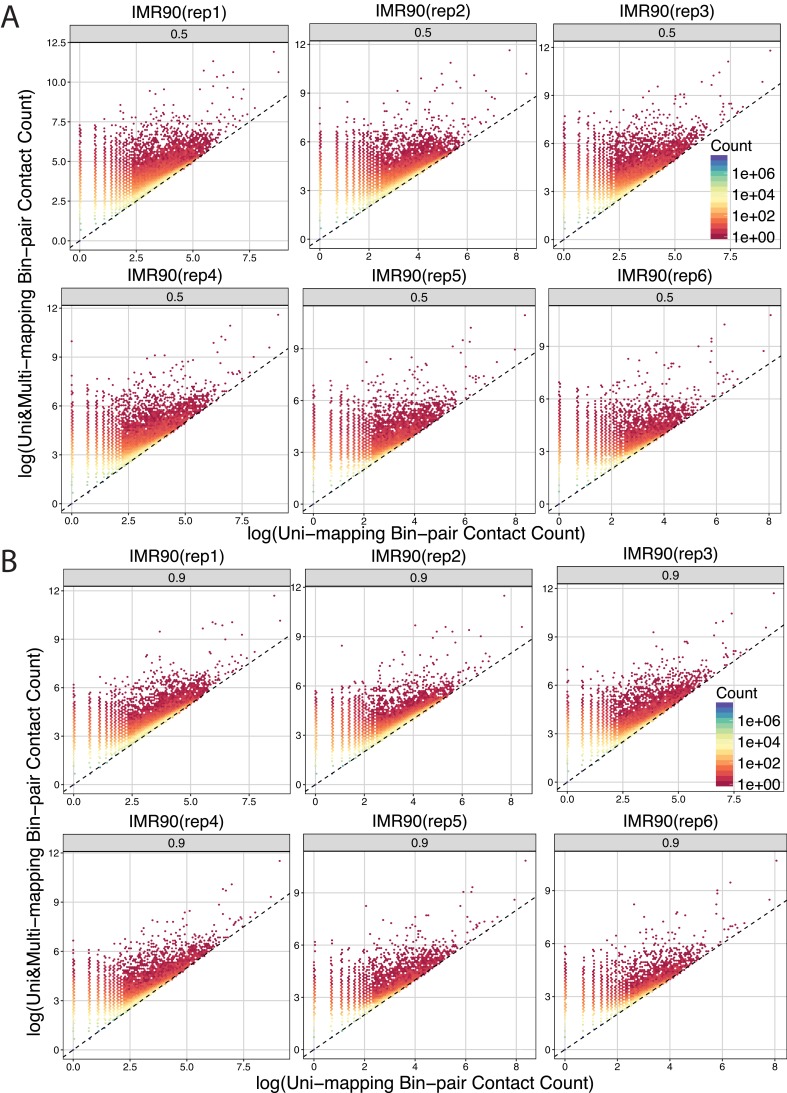
Bin coverage improvement of raw contact matrices under Uni&Multi-setting compared to Uni-setting for IMR90 at the individual replicate level for two different allocation probability thresholds.Uni&Multi-setting for (A) includes multi-reads with a posterior probability > 0.5, whereas (B) depicts more strict filtering with an allocation probability > 0.9 The dashed line is y = x. mHi-C rescues multi-reads from valid ligation fragments, resulting in a significant increase in contact counts.